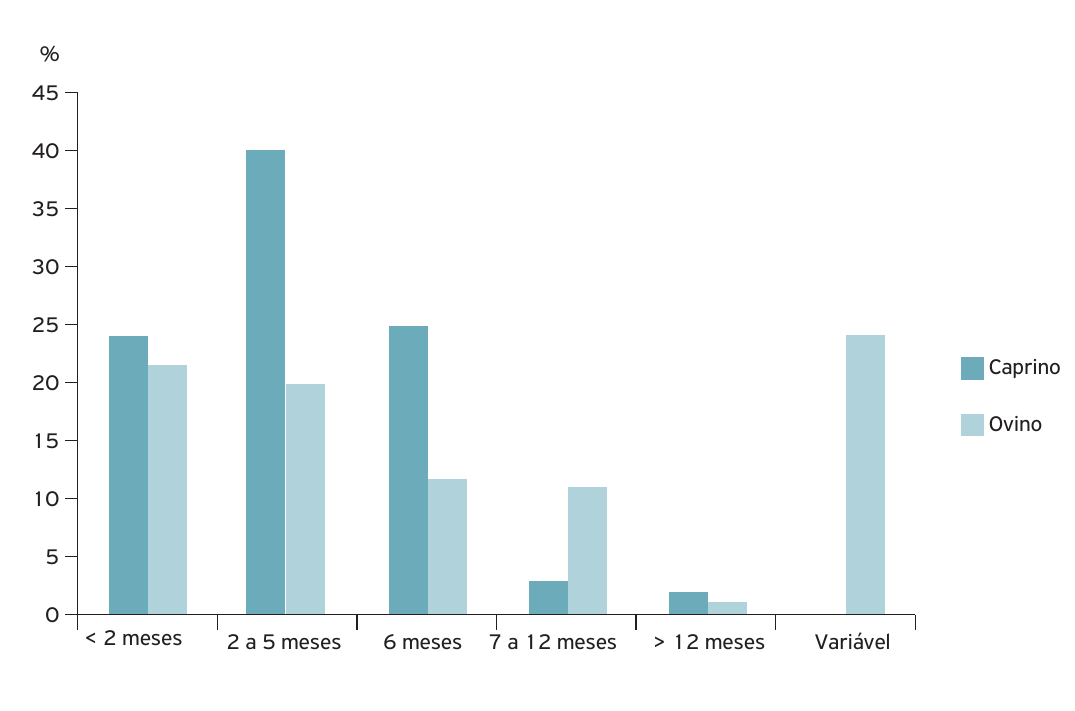
Figura 1. Caprinocultura e ovinocultura: intervalo de alternância de vermífugo (%), estado de São Paulo,